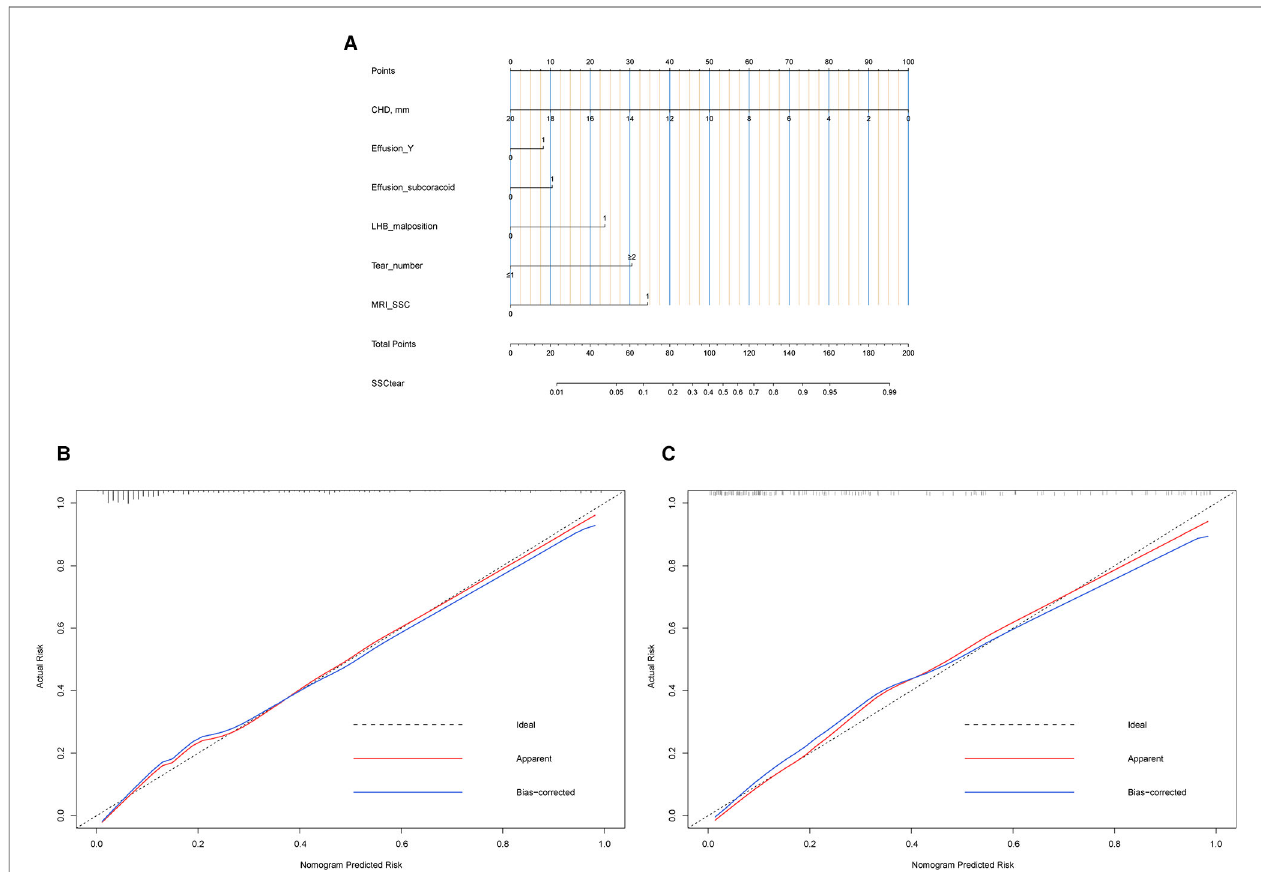
FIGURE 4 | Nomogram and calibration. ( A ) Nomogram. To use the nomogram, fi nd the position of each variable on the corresponding axis, draw a line to the points axis for the number of points, add the points from all of the variables, and draw a line from the total points axis to determine the tear risk of SSC tendon at the lower line of the nomogram. ( B ) Calibration plot of the training data set. Validity of the predictive performance of the nomogram in estimating the risk of SSC tendon tear with the 1,000-sample bootstrapped calibration plot. The calibration plot showed good agreement between predicted and observed outcomes in the training data set. ( C ) Calibration plot of validation data set. The calibration plot showed good agreement between predicted and observed outcomes in the validation data set.